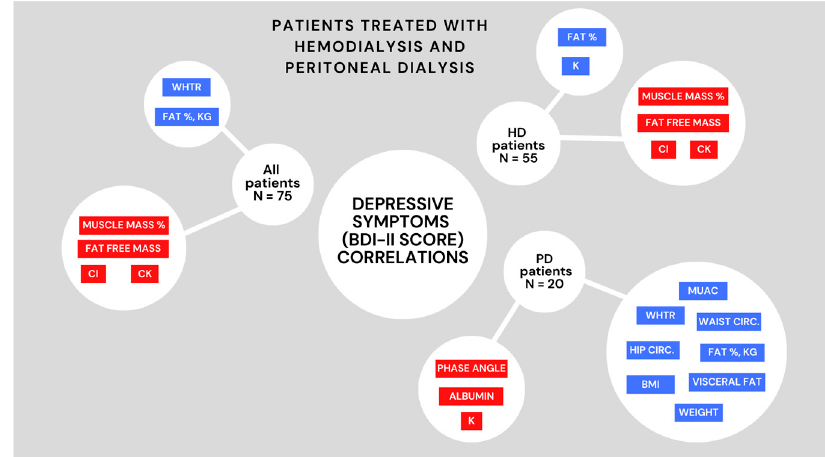
Figure 1. Significant correlations between depressive symptoms and measured parameters.